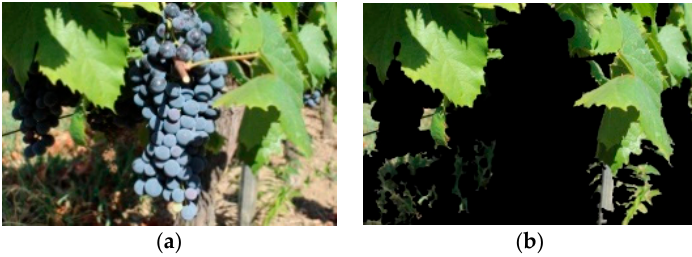
Figure 7. The proposed method for grapevine leaf segmentation: ( a ) An original image from the DRGV database; ( b ) segmented leaf output.